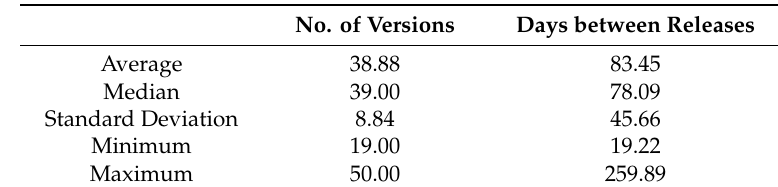
Table 4. Statistics based on project version and release periods.